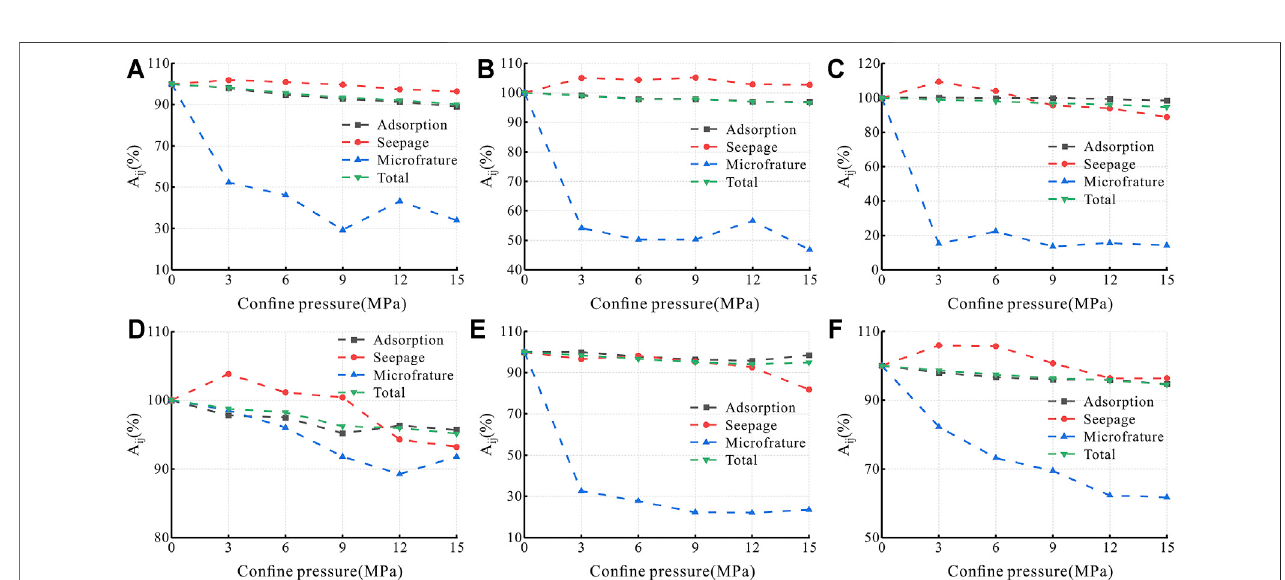
FIGURE 7 | Relationship between T 2 spectral area ratio and con fi ning pressure.